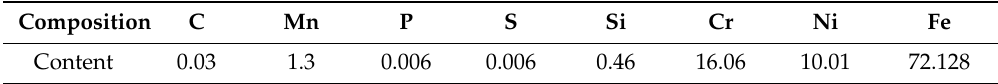
Table 1. 316L stainless steel composition (% mass